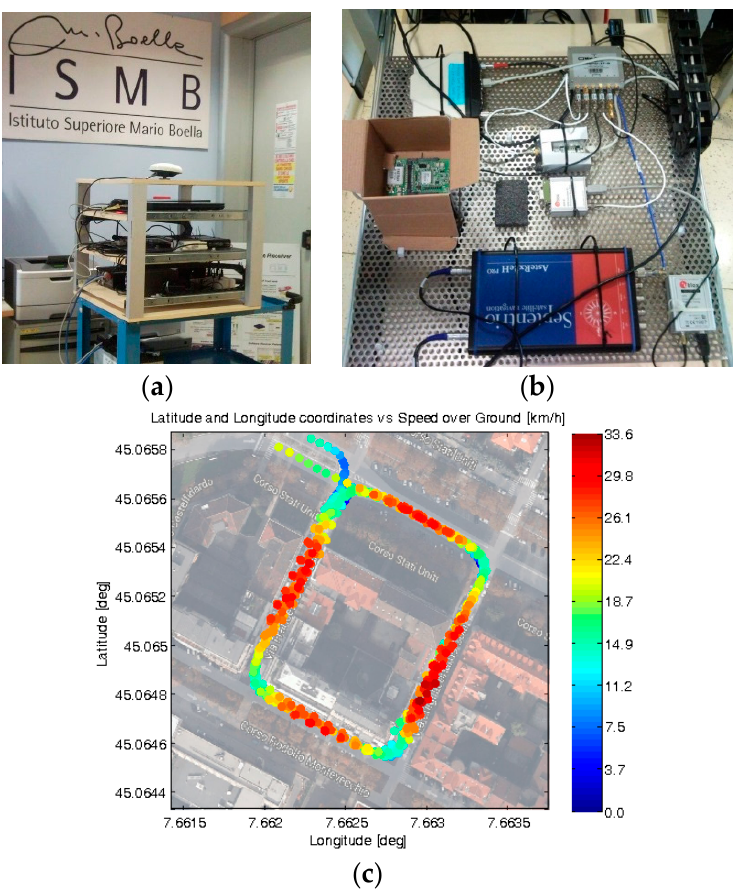
Figure 3. Measurement setup for vehicular data collections: ( a ) Experimental setup; ( b ) Devices under test; ( c ) Example of logged positions and speeds on a selected path, shown in Google Maps © .